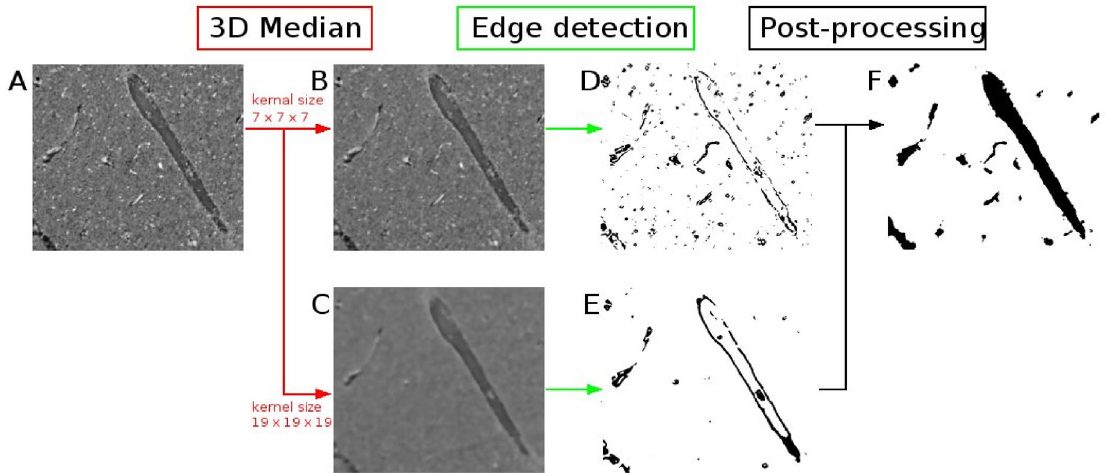
Figure 5. Vessel segmentation from phase-contrast microtomography with 0.94 µm isotropic voxel. ( A ) Phase- contrast microtomography from sample 1, containing several vessels (image height = 0.5 mm, width = 0.6 mm). Intermediate steps show results of applying median filter ( B , C ) and Deriche-Canny edge detection ( D , E ). Post- processing includes island removal, closing operation and fill holes. ( F ) Segmentation result shown as a binary image.